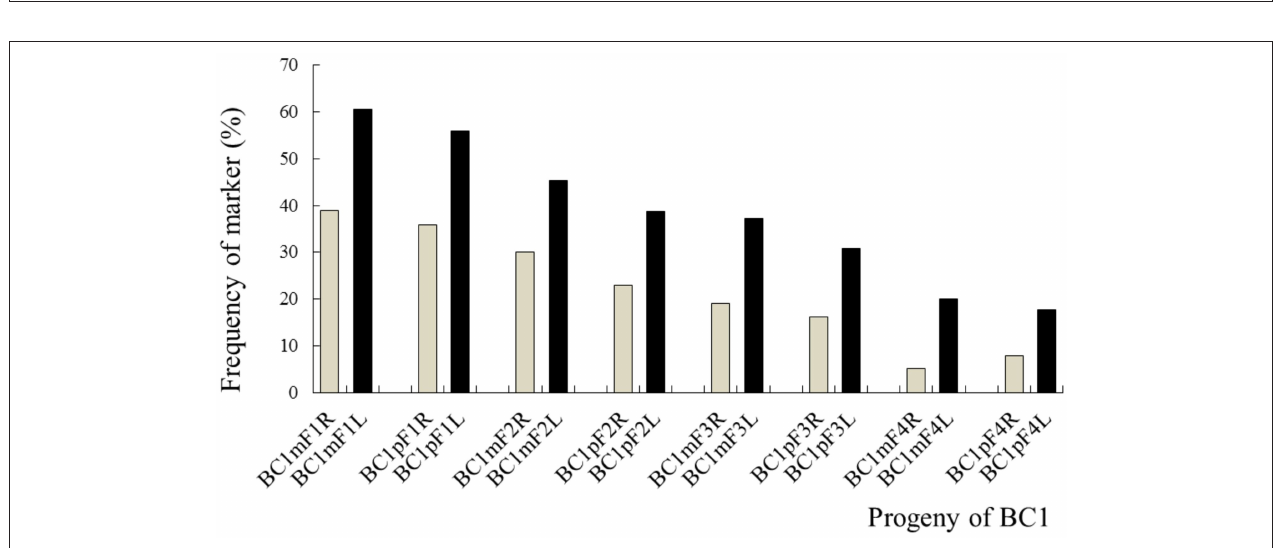
FIGURE 7 | (14-16). Anaphase II: (14). one lagging chromosome; (15). two lagging chromosomes; (16). one chromatid bridge. (17-18). Telophase II: (17). one micronucleus; (18). one chromatid bridge. BC1mF4R indicates the glyphosate-tolerant fourth-generation progenies of the first backcross generation (BC1) obtained from wild Brassica juncea × F1R. F1R indicates the glyphosate-tolerant F1 hybrids obtained from wild B. juncea × glyphosate-tolerant transgenic oilseed rape. Progenitors in front of the × are always the maternal plants, and progenitors after the × are always the paternal plants. Red arrows indicate the abnormal meiosis of pollen mother cells.